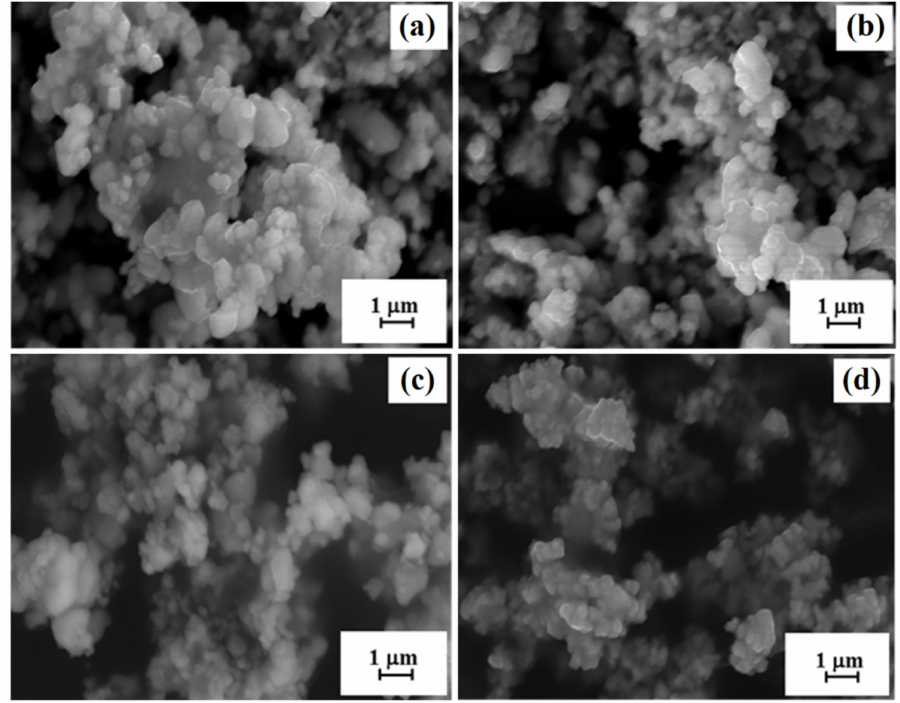
Figure 1. SEM images observed for ceramic powders: ( a ) BLTF1, ( b ) BLTF2, ( c ) BLTF3, and ( d ) BLTF4 after